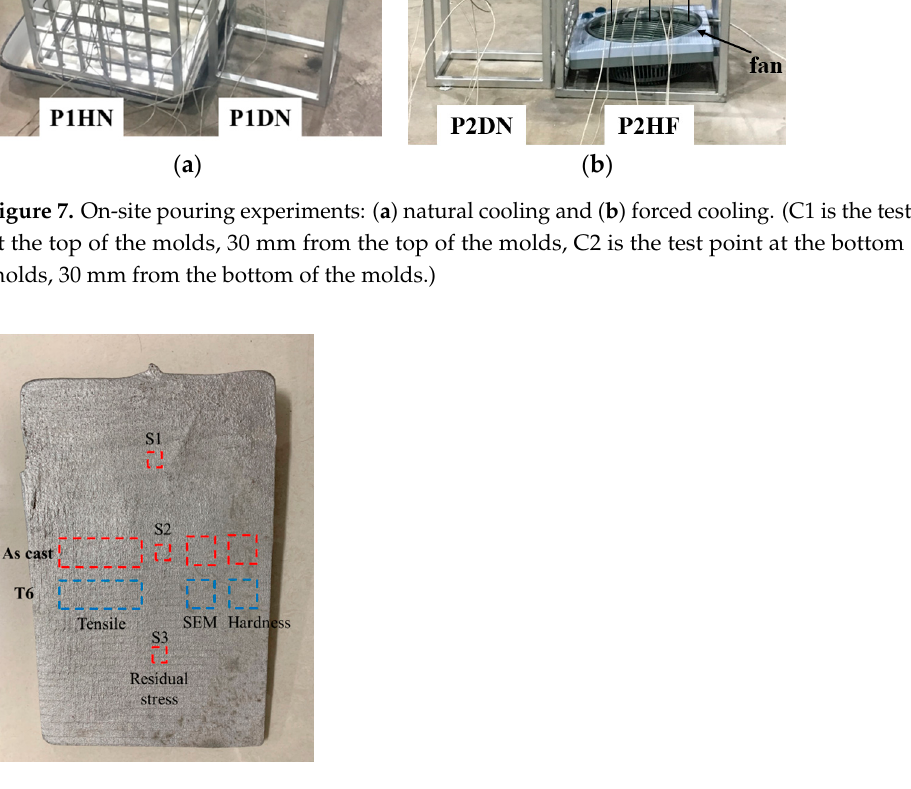
Figure 8. Schematic for the sampling position of the casting specimen. (S1 is the test point at the top of the castings, 50 mm from the top of the castings, S2 is the test point at the middle of the castings, S3 is the test point at the bottom of the castings, 50 mm from the bottom of the castings.)